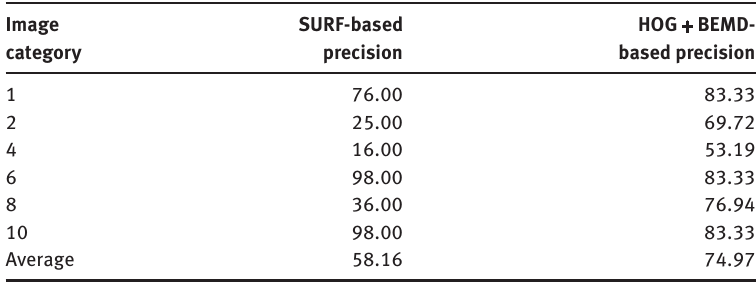
Table 2: Precision and Recall Values with Addition of